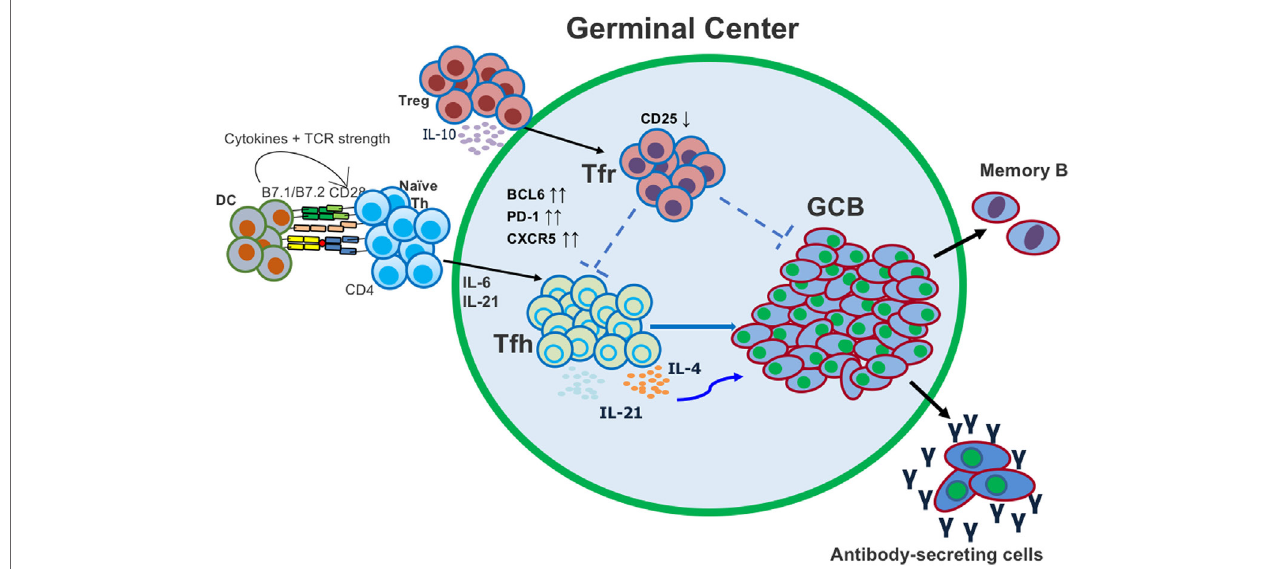
FiGURe 1 | Follicular helper T (Tfh) and T follicular regulatory (Tfr) cells both act in the germinal center (GC) to regulate the generation of antigen (Ag)-specific antibody-secreting cells. Tfh cells differentiate from conventional CD4 T cells after activation with Ag and dendritic cell (DC) presentation. Tfr cells differentiate from conventional regulatory T cells (Tregs) and migrate into the